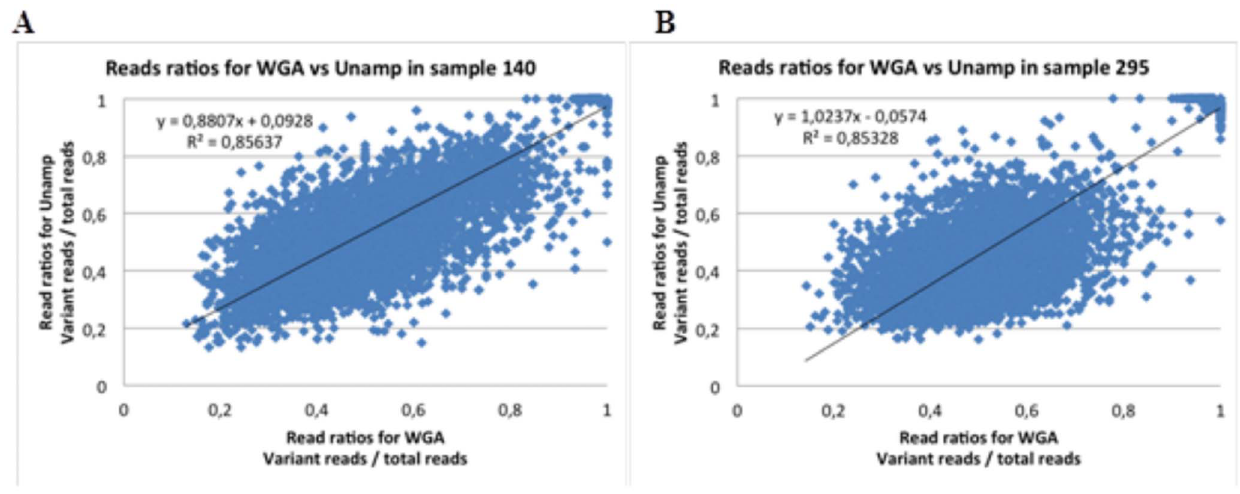
Table 4. Comparison of unique and tumor specific variants in unamplified DNA, WGA DNA and RNA.